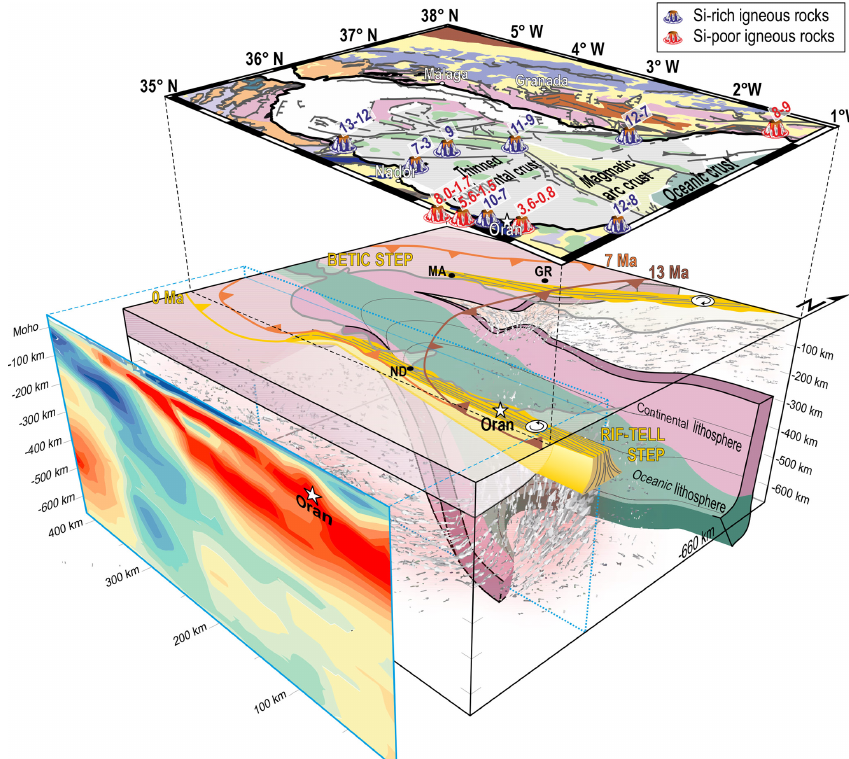
Figure 10. (a) Conceptual 3-D model of the western Mediterranean lithosphere, stripped from the overlying crust (modified after Mancilla et al., 2015). The original sketch showed the geometry of the lithosphere and its relation to the subducted oceanic slab as observed by tomographic studies (Spakman and Wortel, 2004; García-Castellanos and Villaseñor, 2011; Bezada et al., 2013). MA: Málaga; GR: Granada; ND: Nador. The superposed schematic geological map is presented in Fig. 1a. Types and ages of volcanism are compiled after Maury et al. (2000), Duggen et al. (2005) and Booth-Rea et al. (2007). On the left, seismic tomography is shown for an E–W cross section close to the Oran volcanic field (light blue dashed line in the 3-D sketch) after van Hinsbergen et al. (2014). Brown, orange and yellow solid lines indicate the estimated position of the subduction front at 13, 7 and 0Ma, respectively (Booth-Rea et al., 2007 and Guillermo Booth-Rea, personal communication, 2018). The Betic and Tell–Rif STEP faults are constrained after Hidas et al. (2016a), Mancilla et al. (2018) and Chertova et al. (2014a, b). Mantle flow in the Iberian and north African slab windows is inspired by the work of Menant et al. (2016). The white star shows the provenance of Oran mantle